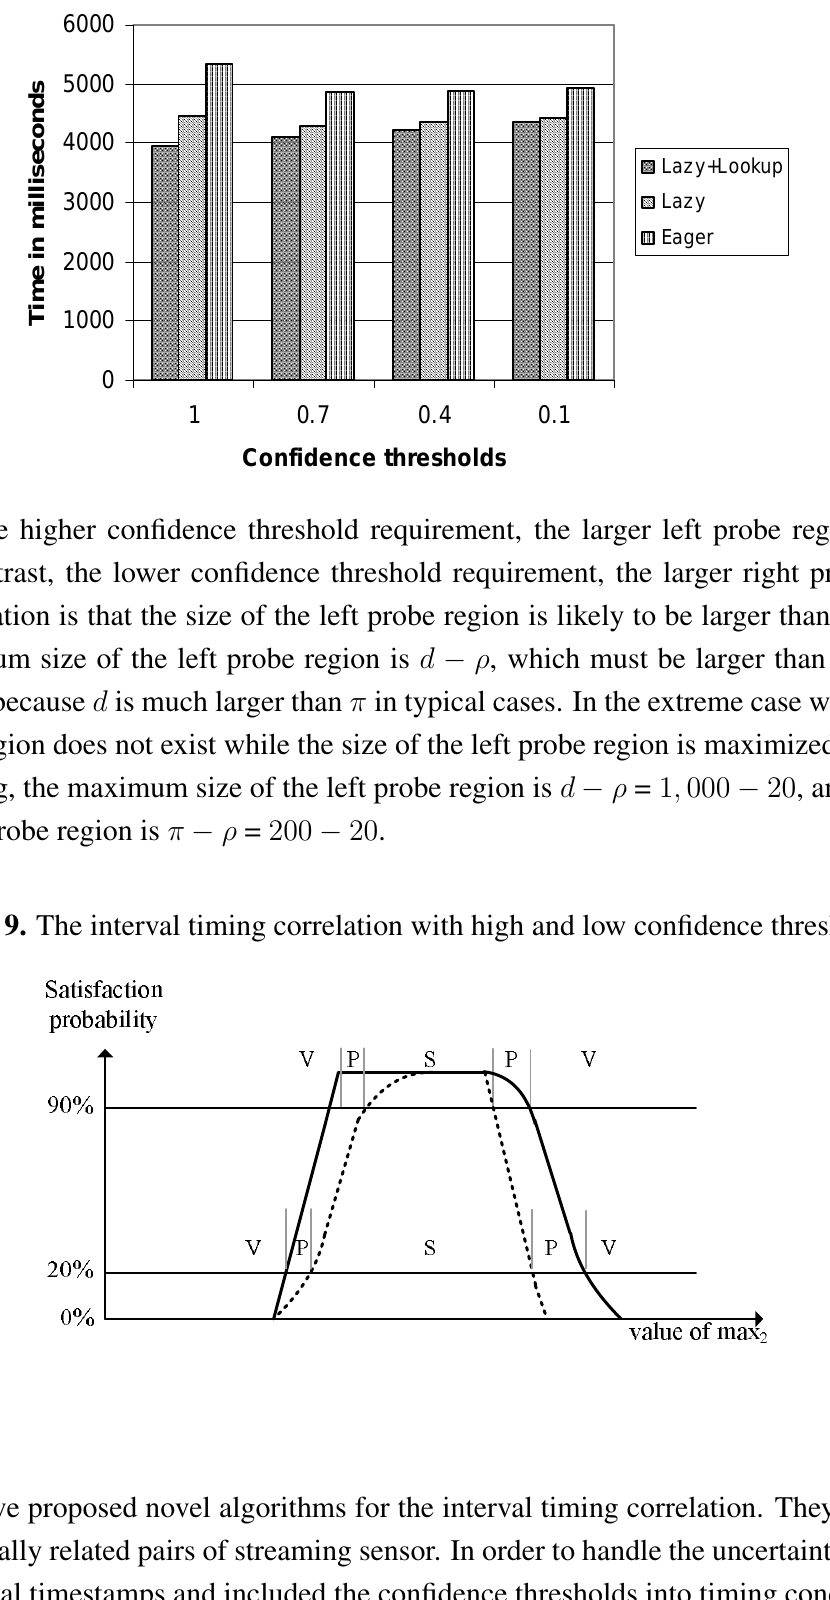
Figure 8. The execution times under various confidence thresholds.